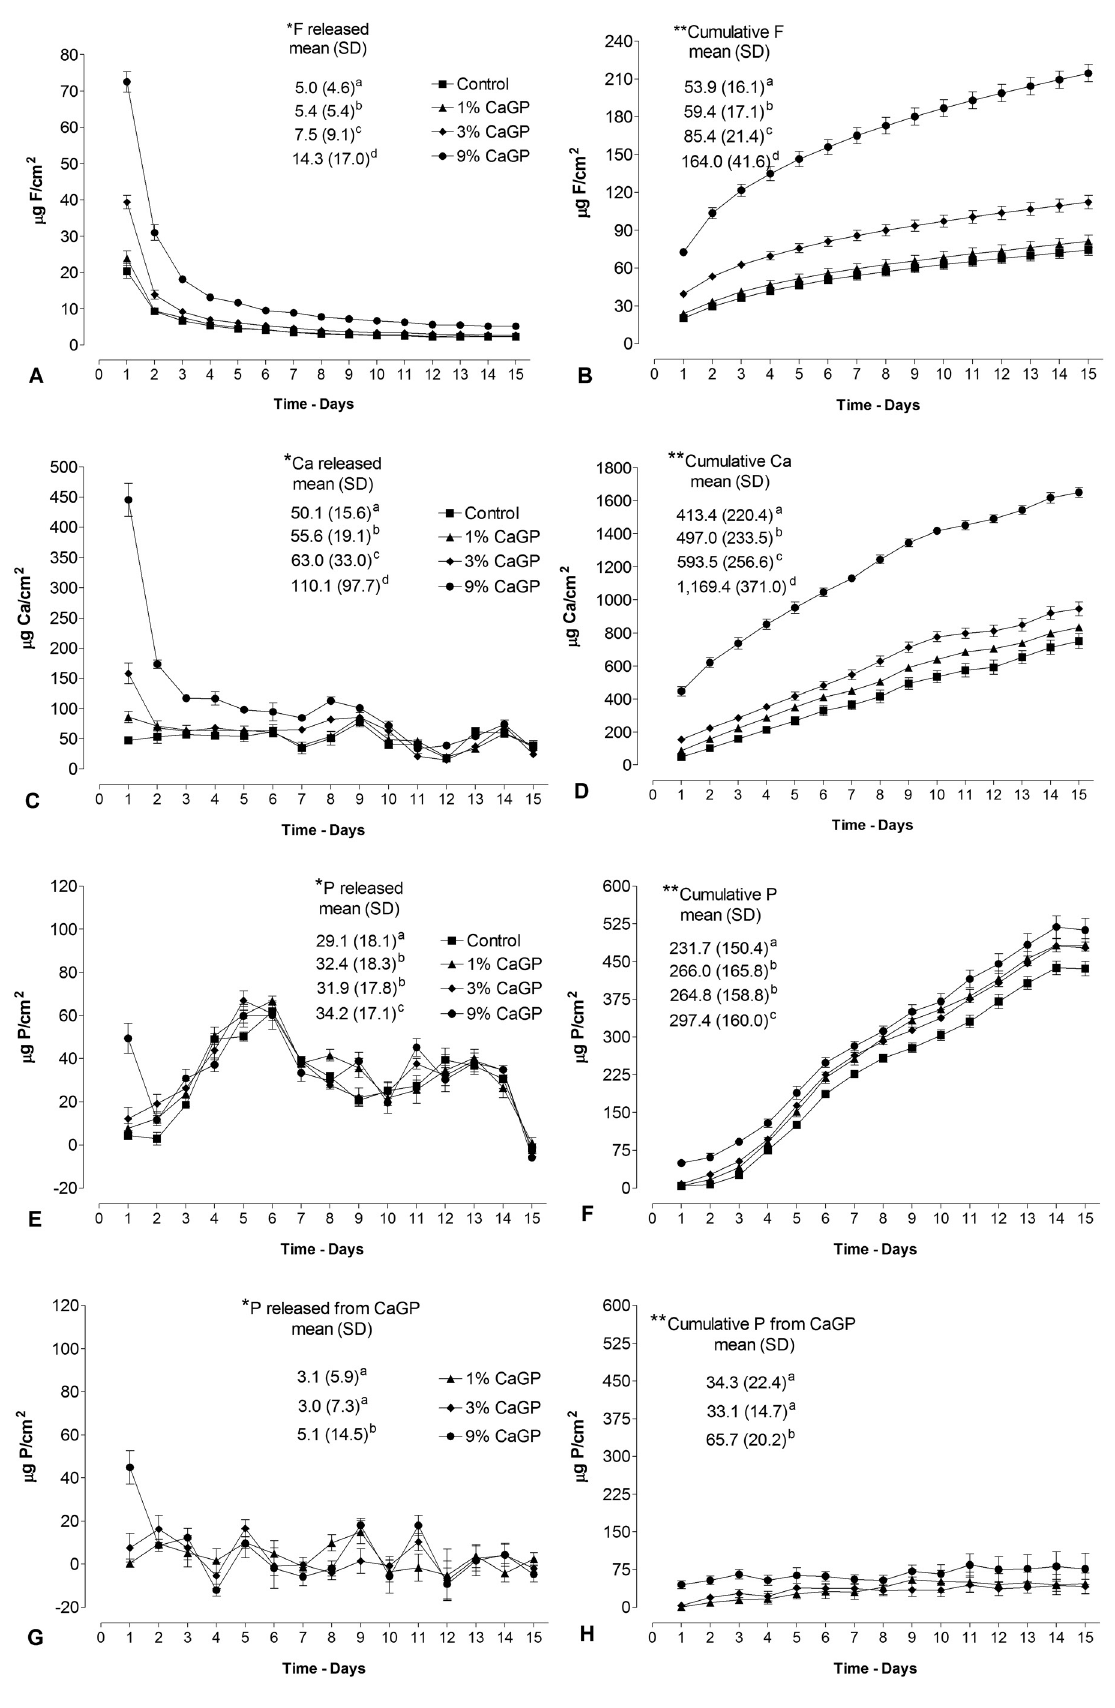
Figure 3- Release (mean) of F (A), Ca (C), P (E) and P of CaGP (G) in solutions (DE + RE) as function of time (15 days). Cumulative release (mean) of F (B), Ca (D), P (F) and P of CaGP (H) in solutions (DE+RE) according to the groups. Vertical bars represent standard deviation of the mean. *Mean values (SD) of total F, Ca, P and P of CaGP released. **Mean values (SD) of cumulative release of F, Ca, P and P of CaGP. Different letters indicate statistically significant difference between the groups (Student-Newman-Keuls test,